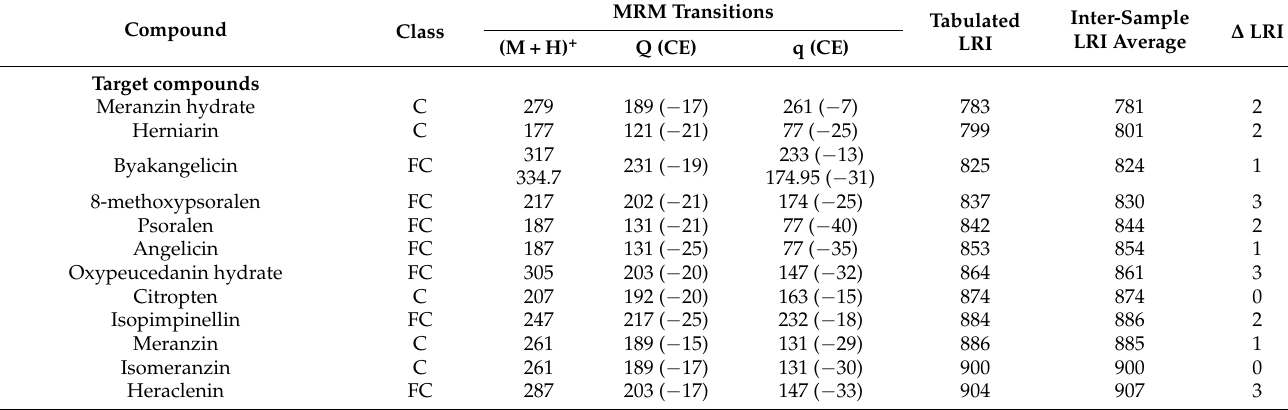
Table 1. MRM conditions (transition, voltages and collision energies). Q, quantifier ion; q, qualifier ion; CE, collision energy, and inter-sample LRI average ( ∆ LRI) for all the analytes in comparison with tabulated values. SIM, Single Ion Monitoring. MRM Transitions Tabulated Inter-Sample ∆ LRI Compound Class LRI Average LRI (M + H) + Q (CE) q (CE) Target compounds Meranzin